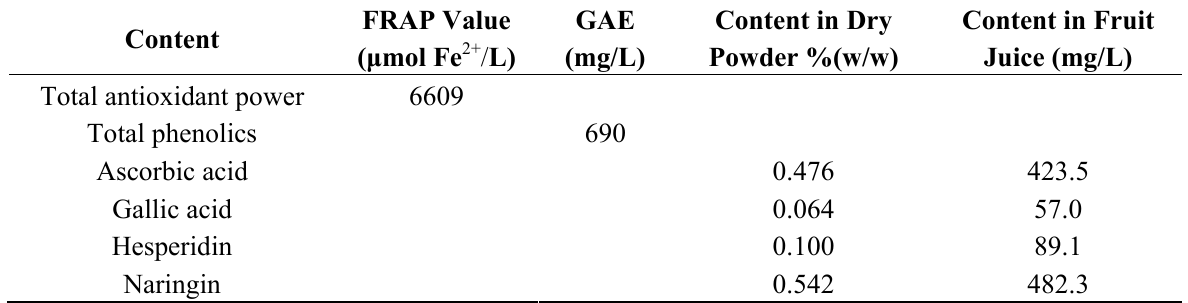
Table 2. Antioxidant capacity, total phenolic contents, ascorbic cotent, and certain